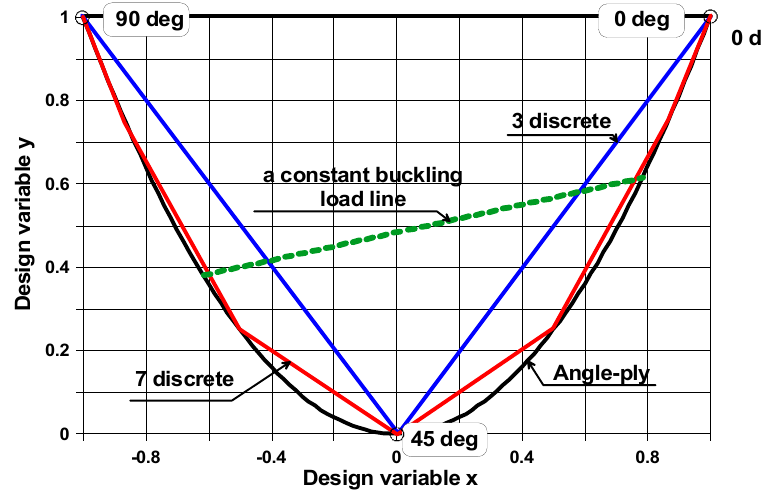
Figure 4. The design space for continuous and discrete design variables.